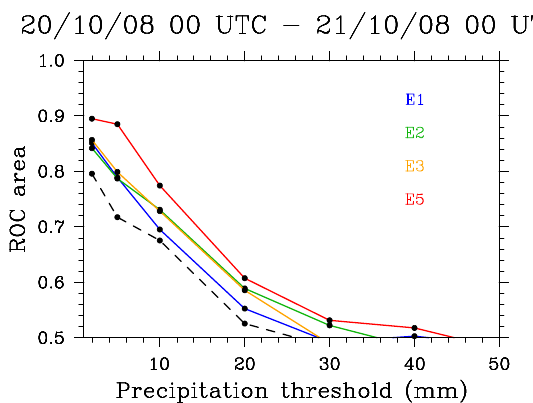
Fig. 13. Area under the ROC curve as a function of the precipitation threshold obtained for the 24h precipitation of the E1, E2, E3, and E5 ensembles (Gard-H´erault case). The dotted line corresponds to the deterministic forecast.